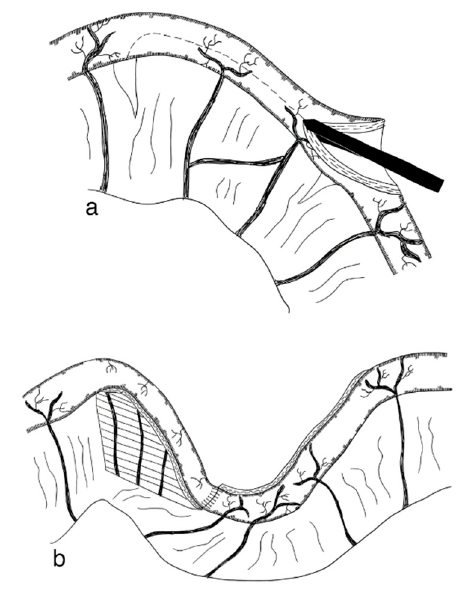
Figure 4. ( a ) Oblique and longitudinal division of the small intestine. ( b ) With a single anastomosis, intestinal continuity can be reestablished. Chahine and Ricketts [122].